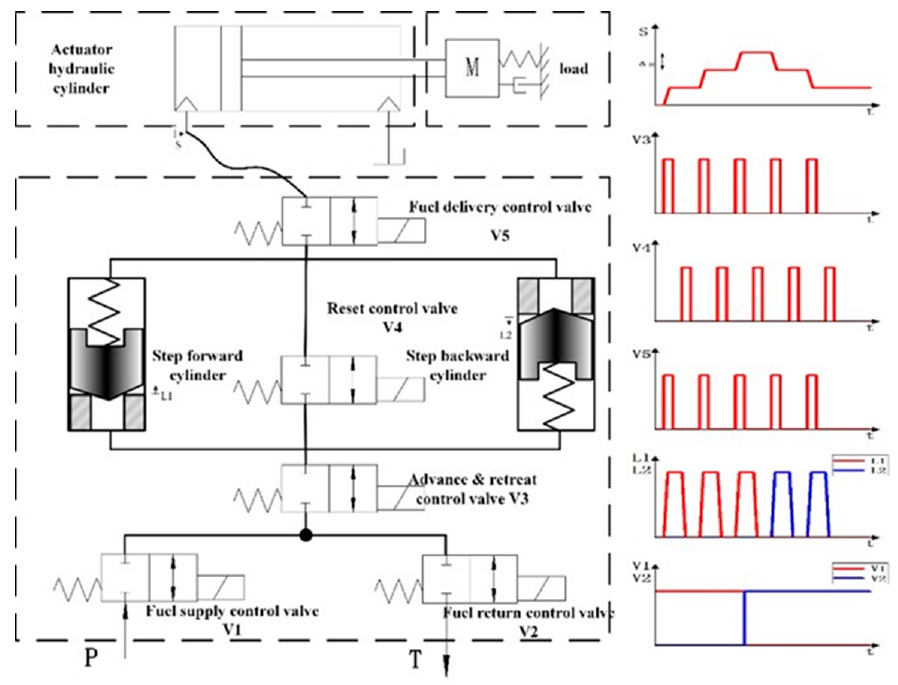
Figure 2. Schematic of the improved hydraulic stepper drive and timing diagram. As is shown in Figure 2, a completely controllable hydraulic stepper drive includes two miniature plunger cylinders and five high speed on/off valves. The hydraulic stepper drive includes six working modes: step forward mode, step backward mode, fast-forward mode, fast-backward mode, position holding mode, and unloading mode. The mode can be switched through the logic action of the high speed on/off valves. The logical relationship between the state of the stepper drive and the control valves is shown in Table 1. Table 1. The relationship between the state of high speed on/off valves and the function of the hydraulic stepper drive. Fuel Supply Control Valve V1